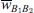
Fitness and distribution of cell types.Parameters: n = 20, μ = 10−4, c
h = 0.2 and concave fitness. U
1
B
2 cells appear at generation 0, which is the point at which the B
1 and B
2 gametes reach mutation-selection equilibrium. (A) Relative advantage of each genotype through time (see Model for details). For B-E, the relative proportion is the sum of a particular cell type divided by the sum of all cells that carry the same genotype. The heteroplasmic category includes all cells with any level of heteroplasmy. B-C shows the distribution of cells carrying the U
1
B
2 genotype (B) and the B
1
B
2 genotype (C). D-E show a more detailed distribution of cell types carrying the B
1
B
2 genotype at generation 1350 (D) and at generation 1820 (E). The decrease in heteroplasmy in B
1
B
2 cells between generations 0–100 is an artifact of introducing U
1 at a frequency of 0.01 (the influx of U
1 gametes homoplasmic for the wild type haplotype converts some heteroplasmic B
1 and B
2 gametes into homoplasmic gametes, which increases the proportion of homoplasmic B
1
B
2 cells). From generations 1350–1820, the proportion of heteroplasmic B
1
B
2 cells decreases (C) but the level of heteroplasmy increases (compare D with E). This more than offsets the decrease in the proportion of heteroplasmic cells and w¯B1B2 continues to decrease (A).